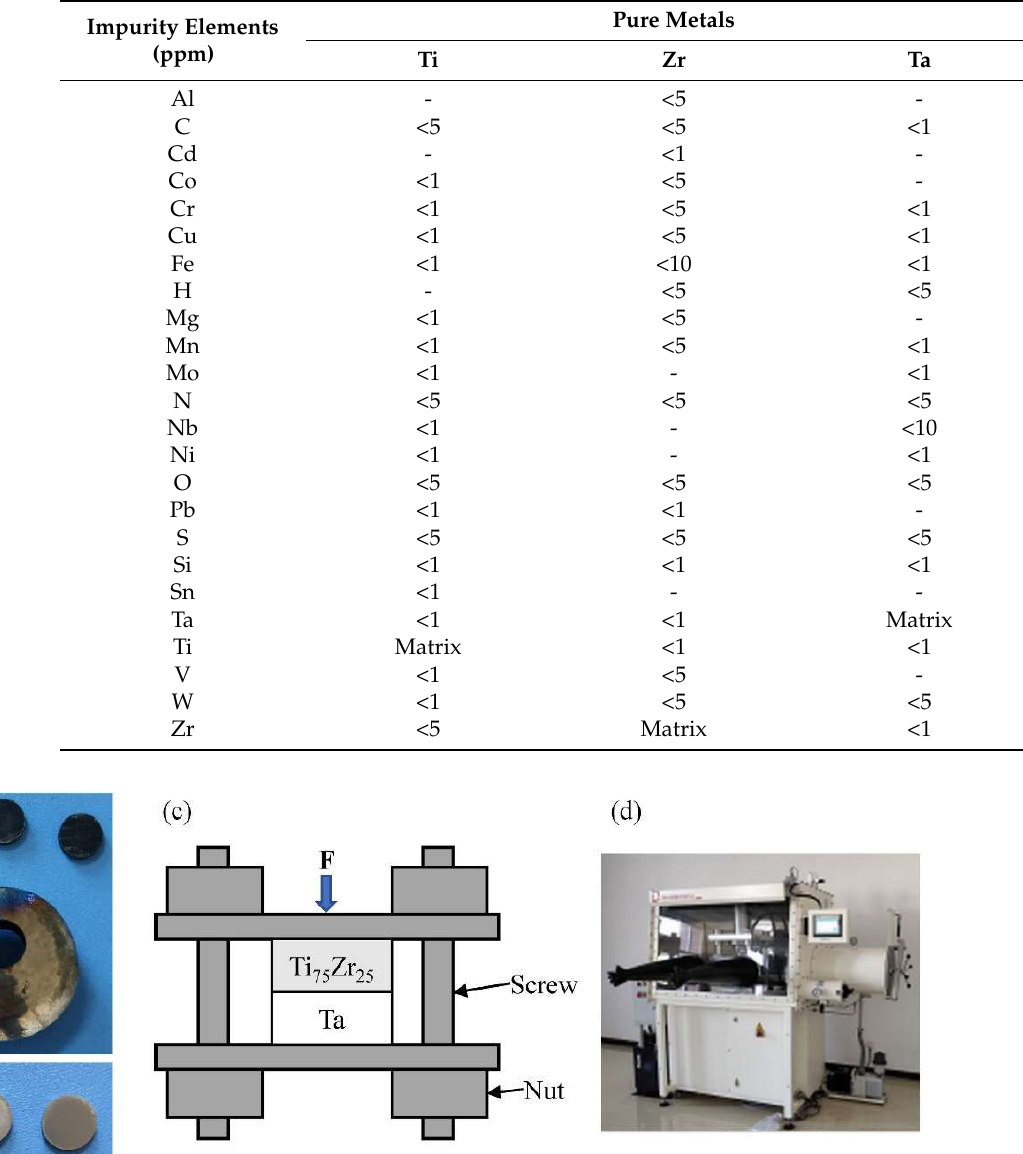
Table 1. The chemical composition of the pure raw metals used.